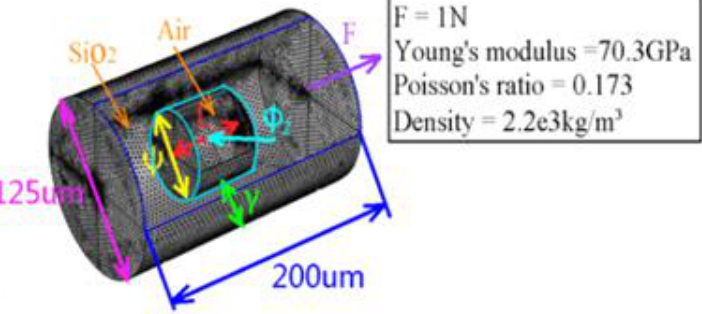
Figure 8. The simulation model of the hourglass microcavity structure and parameter settings.